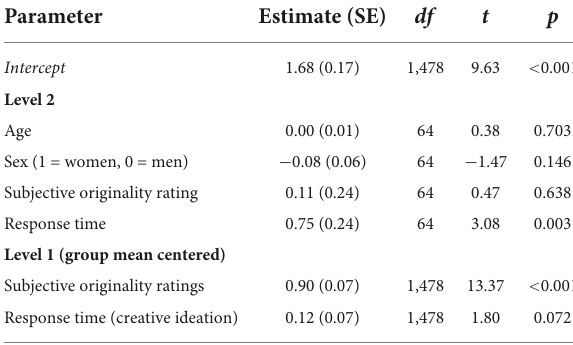
TABLE 3 Multilevel model predicting verbal ABC